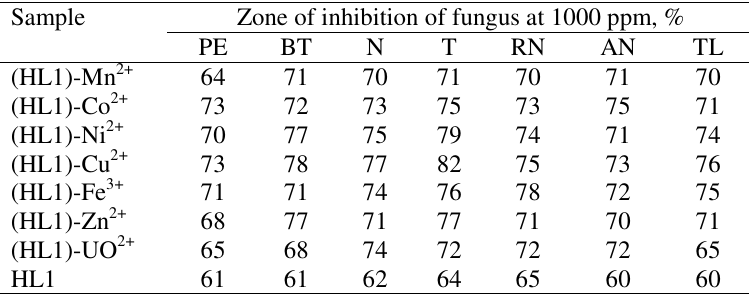
and its metal 1